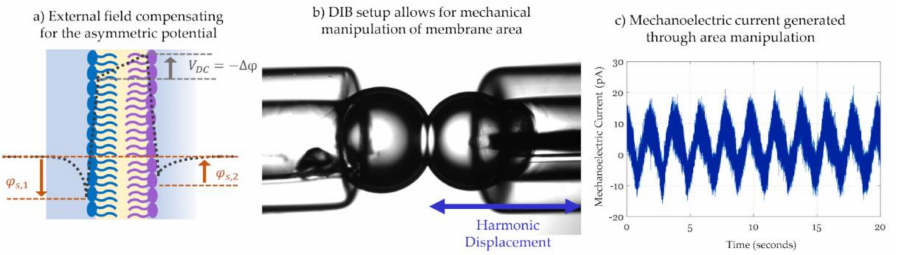
Figure 10. ( a ) Example of the transmembrane potential profile of a generic asymmetric membrane. Having two different leaflet compositions leads to an offset in the overall transmembrane potential, denoted as the membrane asymmetric potential, ∆ ϕ . The latter is composed of the difference between the surface potentials and the dipole potentials between the lipid sheets and can be measured based on the attenuation of an electrocompression-generated current. ( b ) The DIB setup allows for mechanical compression of the membrane through the displacement of one droplet with respect to the other, leading to mechanical adjustment of the membrane area. ( c ) This mechanical displacement leads to the generation of a mechanoelectric capacitive